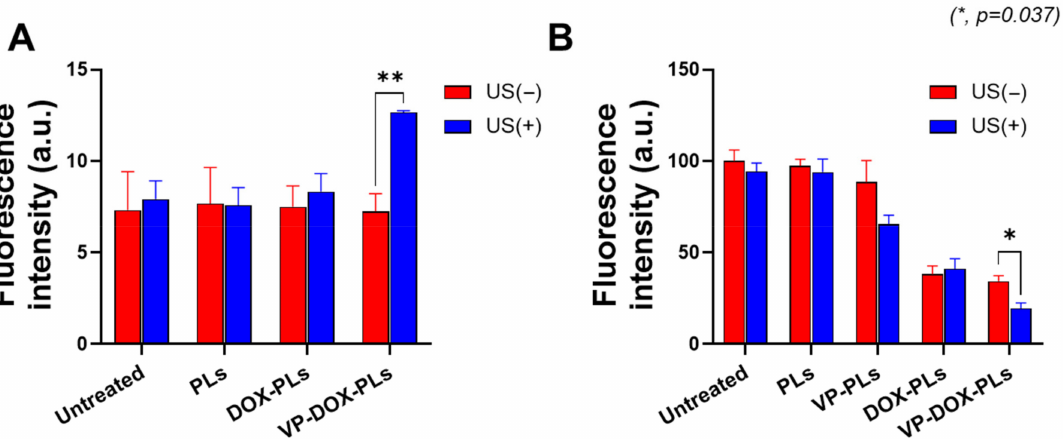
Figure 4. ROS generation and cell viability of VP-DOX-PLs-treated MIA PaCa-2 cells. Untreated group refers to the negative control. ( A ) ROS generation inside MIA PaCa-2 cells treated with various particles. ( B ) Cytotoxicity of VP-DOX-PLs compared with other groups with and without ultrasound. The significance of the difference between experimental and control groups was determined by Student’s t-test. * p < 0.05, ** p <